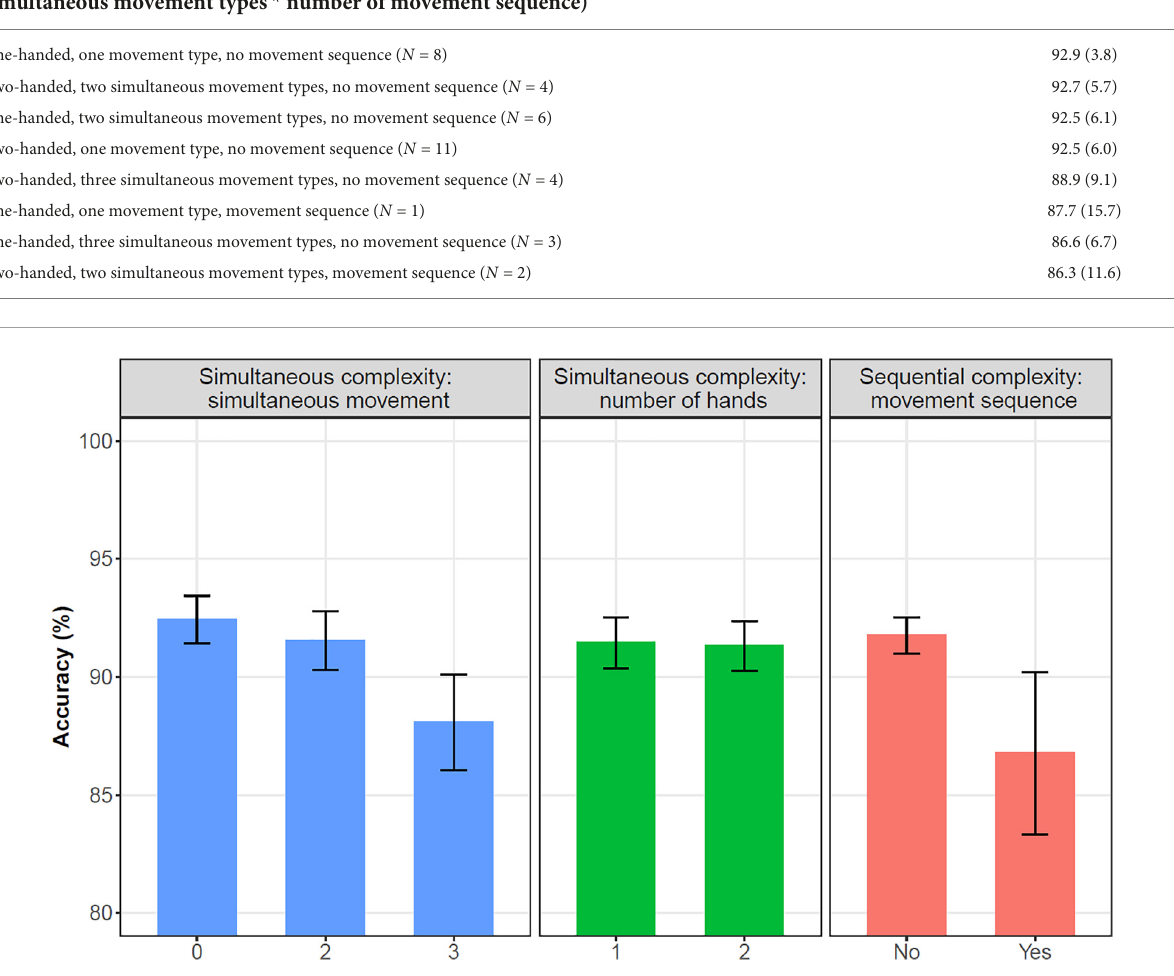
FIGURE5 Overall accuracy (average across 22 participants) in items with differing simultaneous and sequential complexities, with 95% confidence intervals.